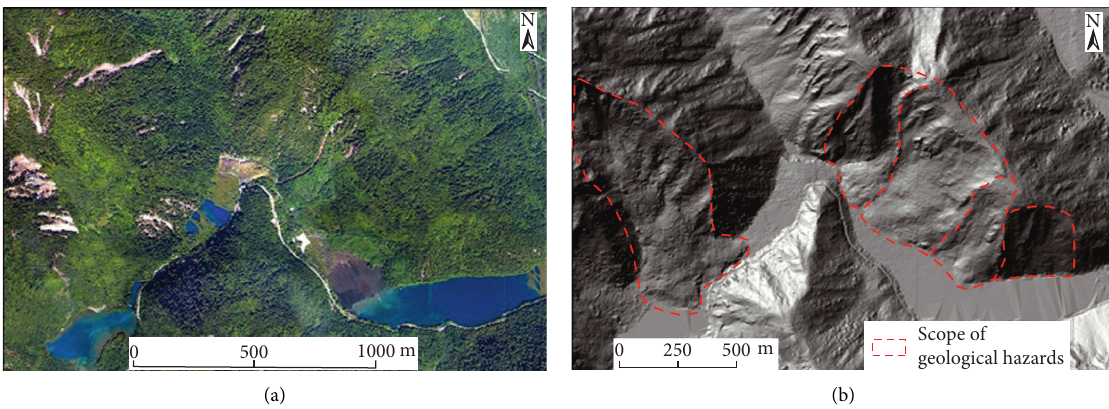
Figure 3: Comparison of an optical image and airborne LiDAR data. (a) Orthophoto map for disaster interpretation. (b) Shadow map of the same mountains in which vegetation has been filtered out based on laser point cloud